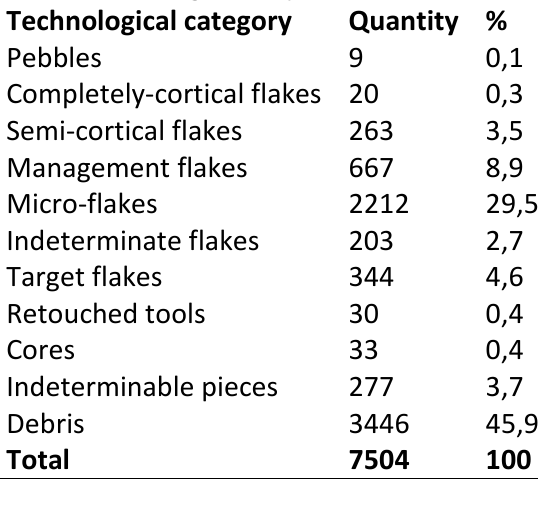
Table 2. Technological composition.